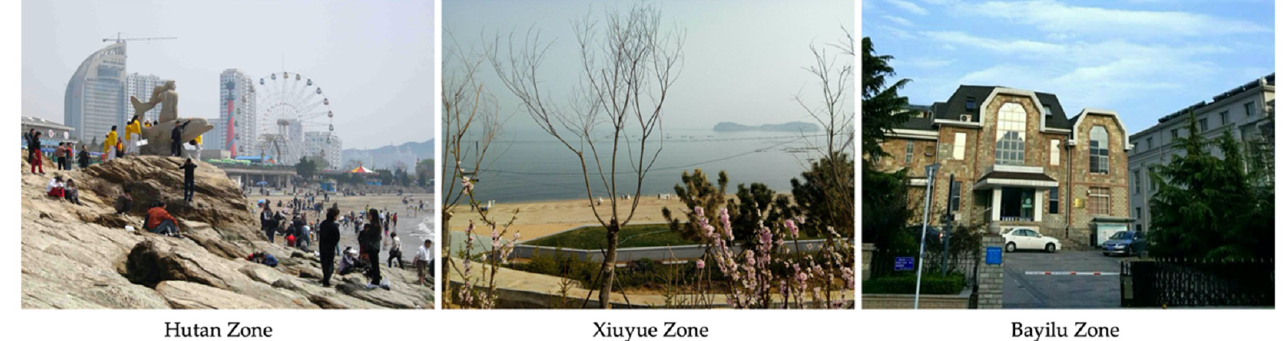
Figure 2. Scenes of Hutan Zone, Xiuyue Zone, and Bayilu Zone. Source: Authors.